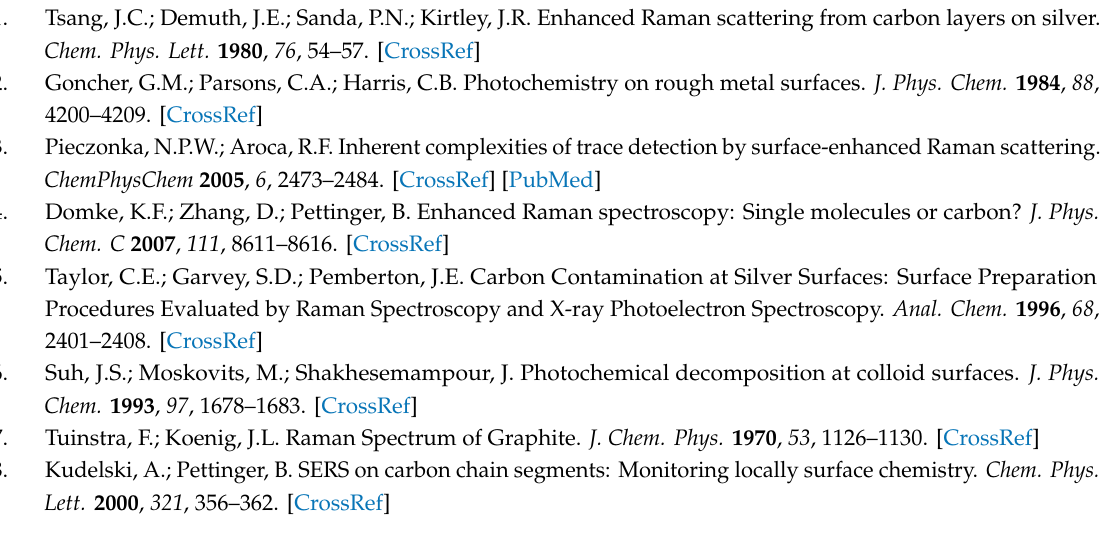
Supplementary Materials: Large-scale AFM images of gold and silver dimer samples, data from Figure 2 without o ff set, SERS spectra from gold and silver dimers under 785 nm excitation, SERS spectra from all sixteen single silver nanolenses and the corresponding AFM images, assignment of background signals in SERS